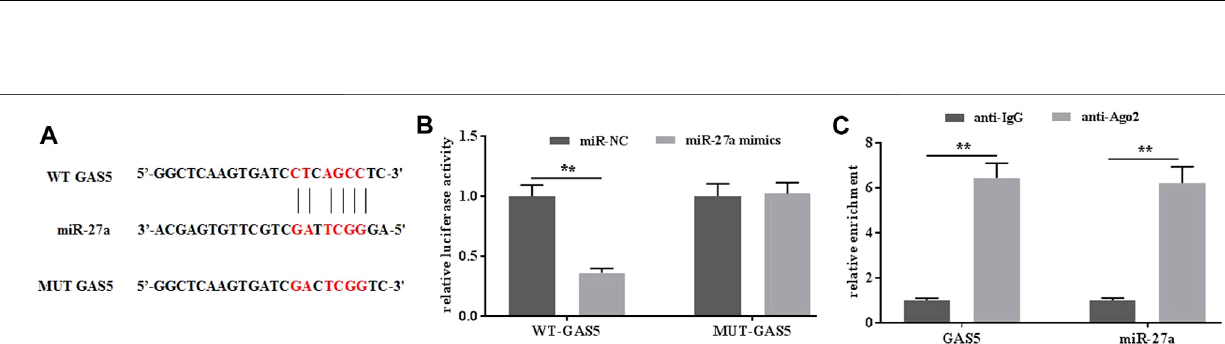
Frontiers in Pharmacology |